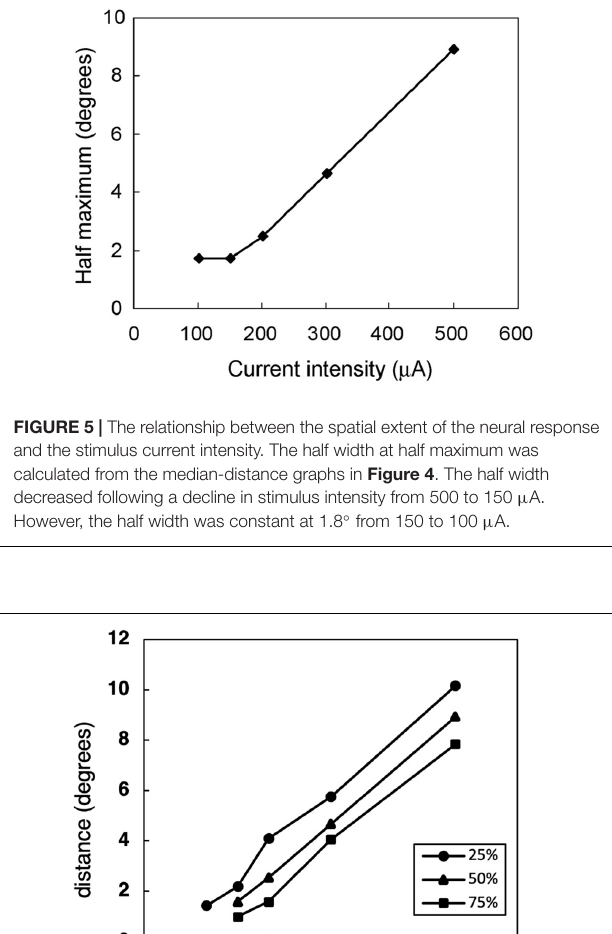
FIGURE 4 | The response probabilities and their median values for the distances between the central point of RF and the stimulating electrode. Open circles indicate the response probability of each unit to the STS. Red circles and lines indicate the median of response probabilities for every 1.5 ◦ . The current intensities in (A–G) were 500, 300, 200, 150, 100, 70, and 50 µ A, respectively.